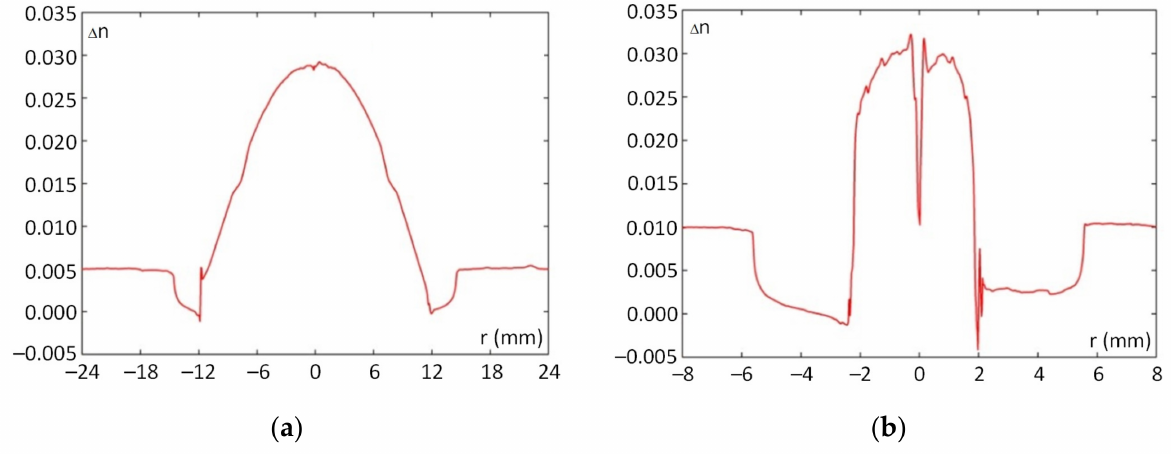
Figure 4. Refractive index profiles of GeO 2 -doped silica rod blanks: ( a ) purchased graded-index rod blank; ( b ) fabricated quasi-step-index rod